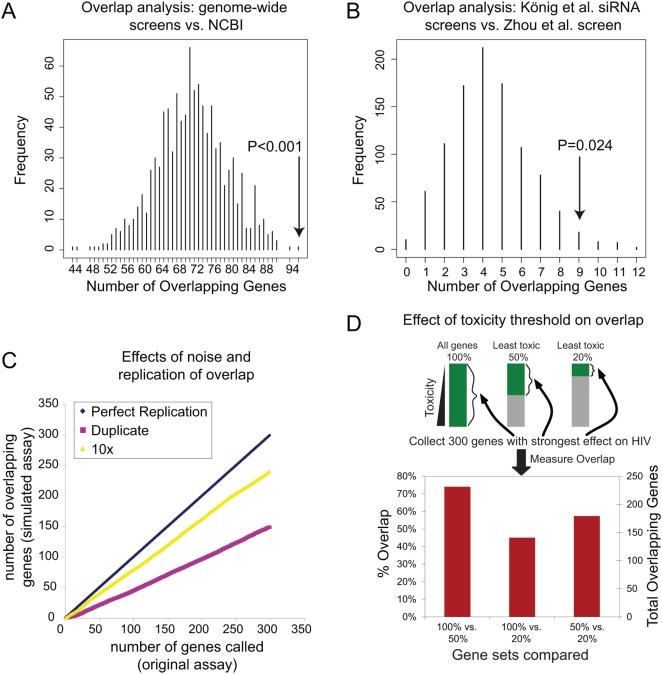
Overlap Analysis to Generate an Empirical p-Value.In each panel the downward arrow indicates the number of genes overlapping between the experimental data sets, and the bars show the frequencies of overlaps in comparisons to random distributions. (A) Simulation of overlap between all of the genes called in genome-wide screens (lists 1–9) and the NCBI database of factors reported to be involved in HIV replication (list 10). One thousand pairs of gene sets were drawn randomly from the set of all human genes, 1,254 to simulate the set of all genes from genome-side screens and 1,434 to simulate NCBI genes, and the overlap in each pair plotted. The experimental overlap was 257 genes. (B) Simulation of overlapping genes between the König et al. and Zhou et al. siRNA screens. The experimental overlap was nine genes. The p-value calculated using the hypergeometric distribution was slightly lower (p = 0.014). (C) Simulation of expected overlap between screens given the measured error between replicates. The standard deviation of infectivity measurements were calculated from the König et al. siRNA screens, and then simulated datasets were generated containing the measured error. For simulations, either two replicates (pink) or ten replicates (yellow) were generated and the overlap quantified. The y-axis: number of top-scoring genes considered in overlap analysis; x-axis: actual number of overlapping genes seen comparing simulated data sets. (D) Choices for toxicity threshold strongly influence the recovery of genes affecting HIV infection. The genes tested in the König et al. siRNA screen were ranked according to toxicity of knockdown, then sets containing 100% of genes, the least toxic 50%, or the least toxic 20% were extracted (top). From each of these, the 300 genes that when knocked down showed the strongest reduction in HIV infection were then selected, and the overlap between gene sets calculated (bottom).